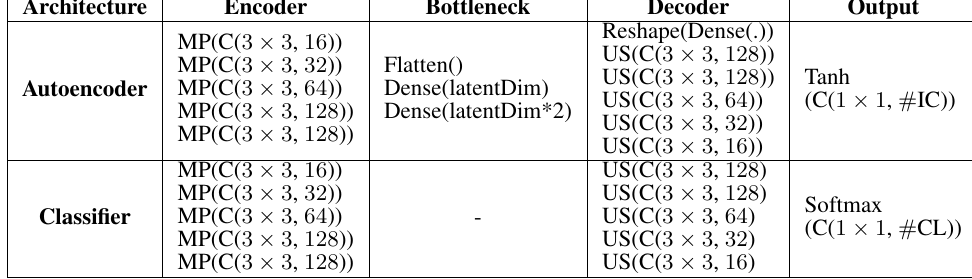
Table 2. Network Architectures. Symbols: C (strided convolution), MP (max-pooling), US (bilinear up-sampling), IC (Input